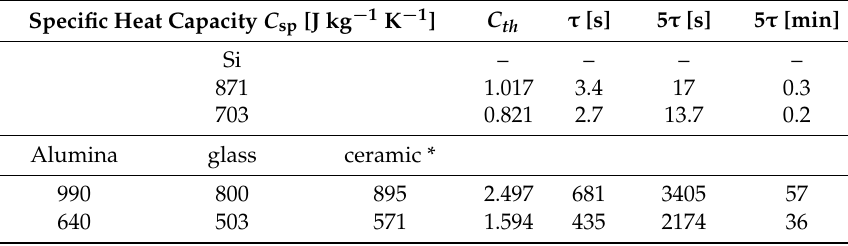
Table A4. Calculated values for C th using Equation (A2), based on different c sp